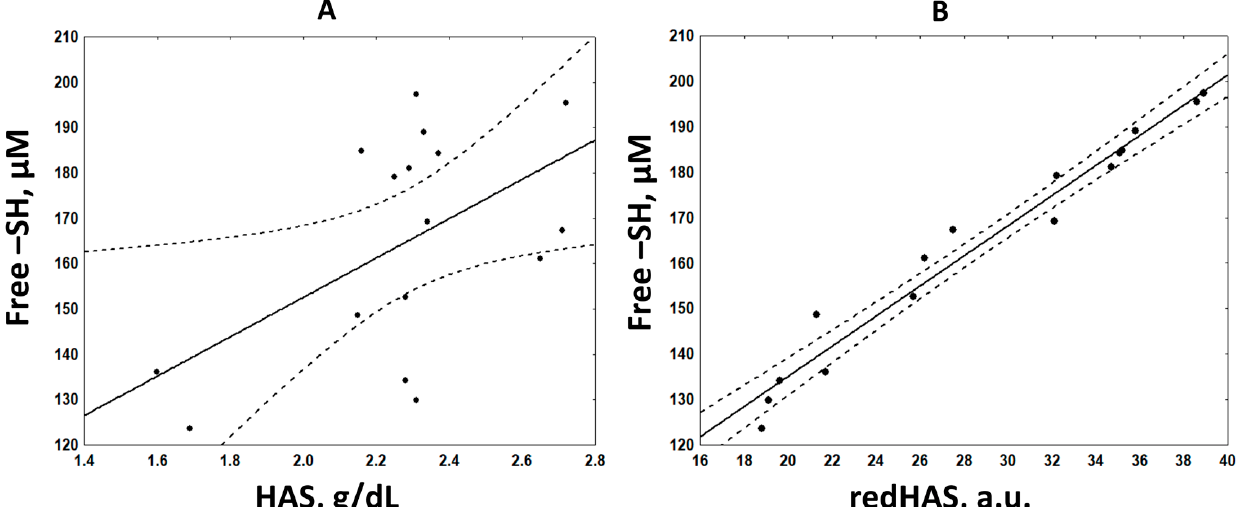
Figure 9. Serum samples from severe COVID-19 patients in the Free-SH group showed a positive correlation with HSA (r = 0.54, p < 0.05, in ( A )) and red HSA measured with SDSL-EPR (r = 0.98, p < 0.05, in ( B )).